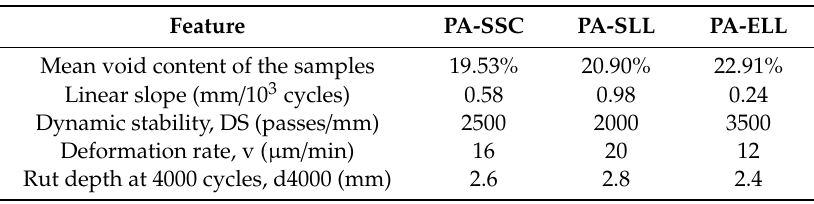
Table 8. Wheel-tracking test